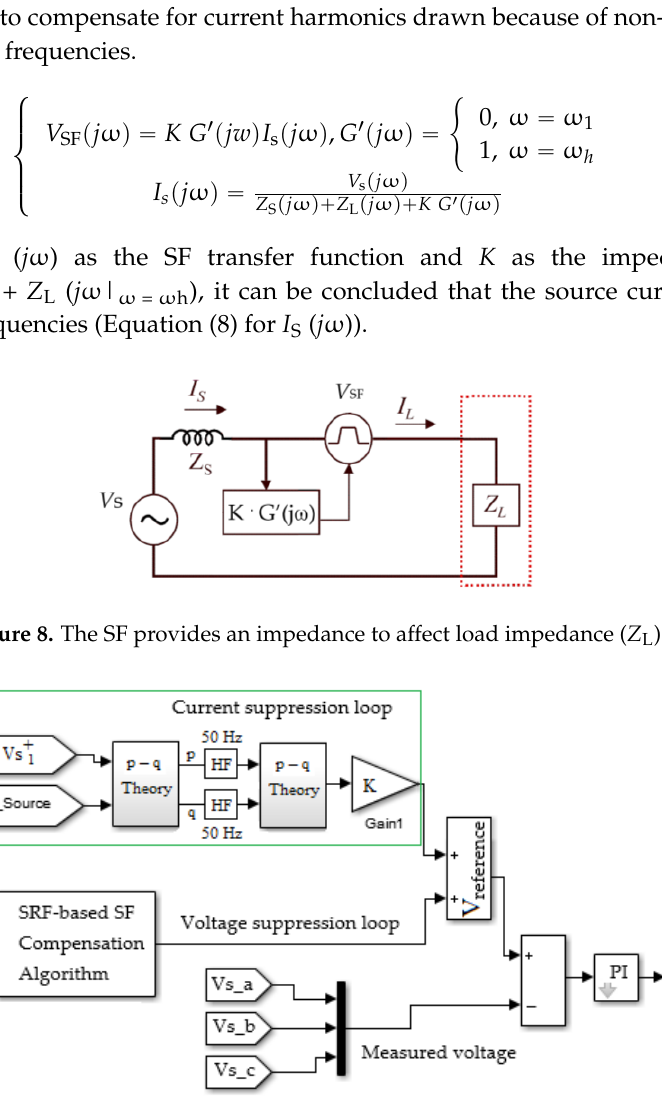
Figure 10. Proposed controller to regulate the DC-link voltage.